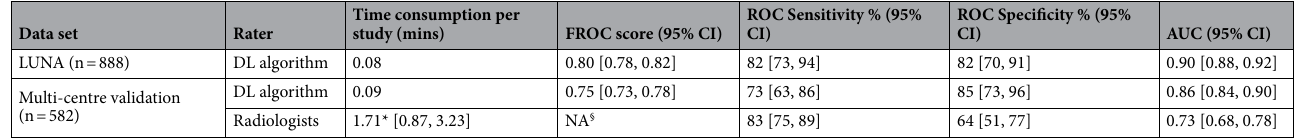
Table 1. Summarized results of performance assessments of DL algorithm and radiologists. *Median, minutes range [min, max] for per-study time consumption in the multi-centre validation set. § FROC score could not be calculated from individual